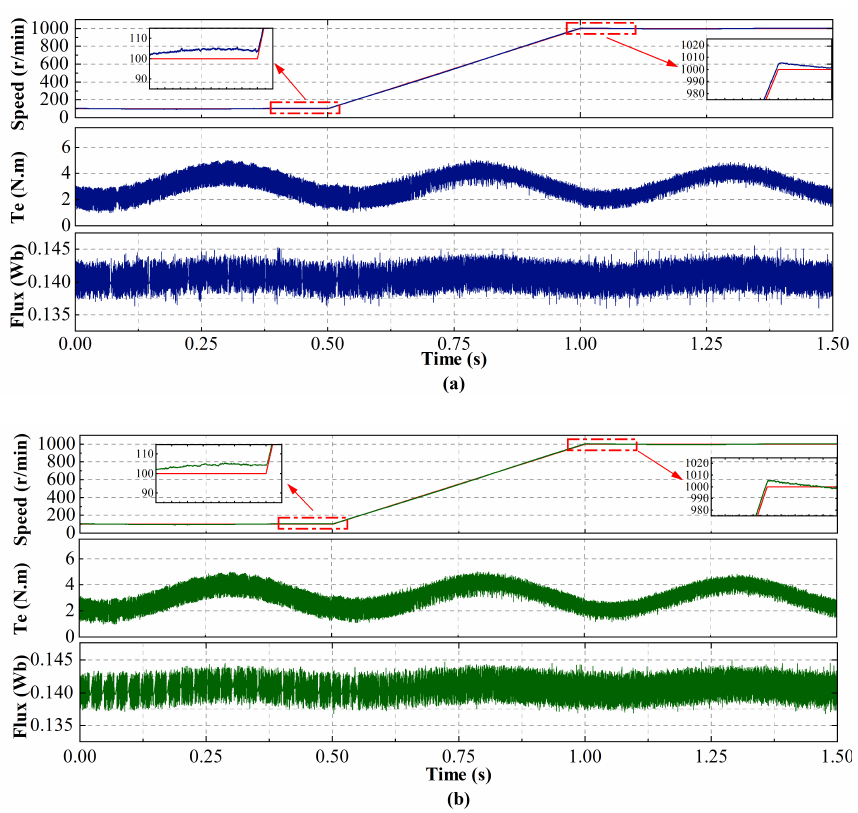
Figure 4. The simulation results of the conventional PPTC and the proposed MF-PPTC with precise parameters. ( a ) Conventional PPTC. ( b ) Proposed